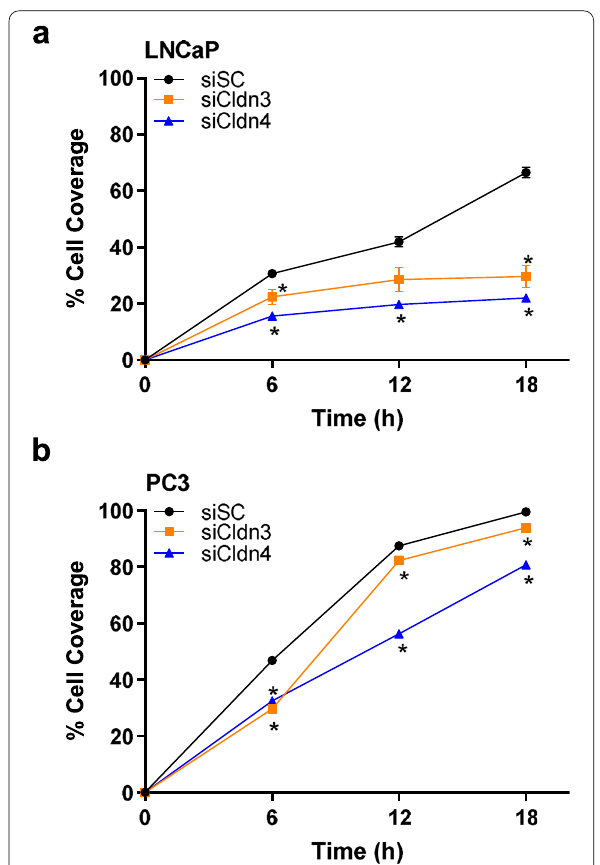
Fig. 6 Cell migration of prostate cancer cells treated with siCldn. The percent difference of ( a ) LNCaP and ( b ) PC3 prostate cancer cell scratch coverage between treatments (siCldn3, orange line and siCldn4, blue line) and control (siSC, black line) was determined at 6, 12, and 18 h. Data are shown as mean SD of 3 to 4 independent ± experiments where * represents p <